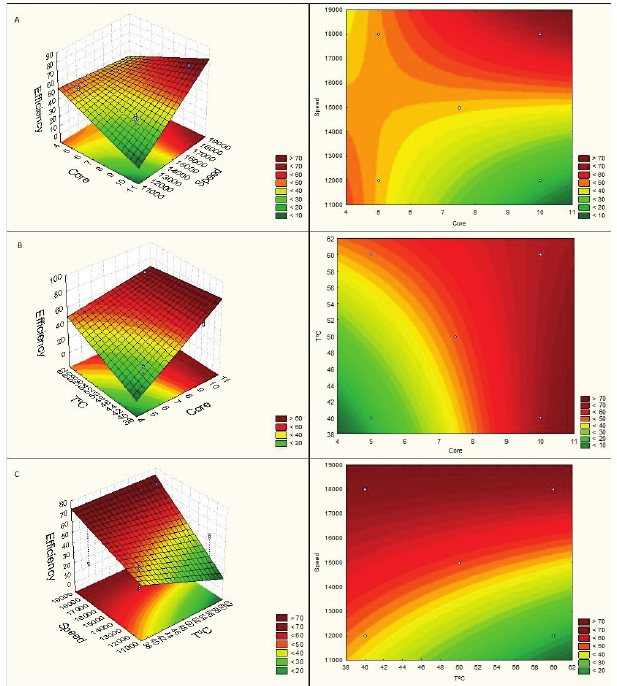
FIGURE 2 - Image of microcapsules coacervates with A. phalerata Mart. oil under coacervation conditions: (A and B) 10 g, 40 ºC, 18000 rpm; (C and D) 10 g, 60 ºC, 18000 rpm increased on 2.500 Kx in Scanning Electron